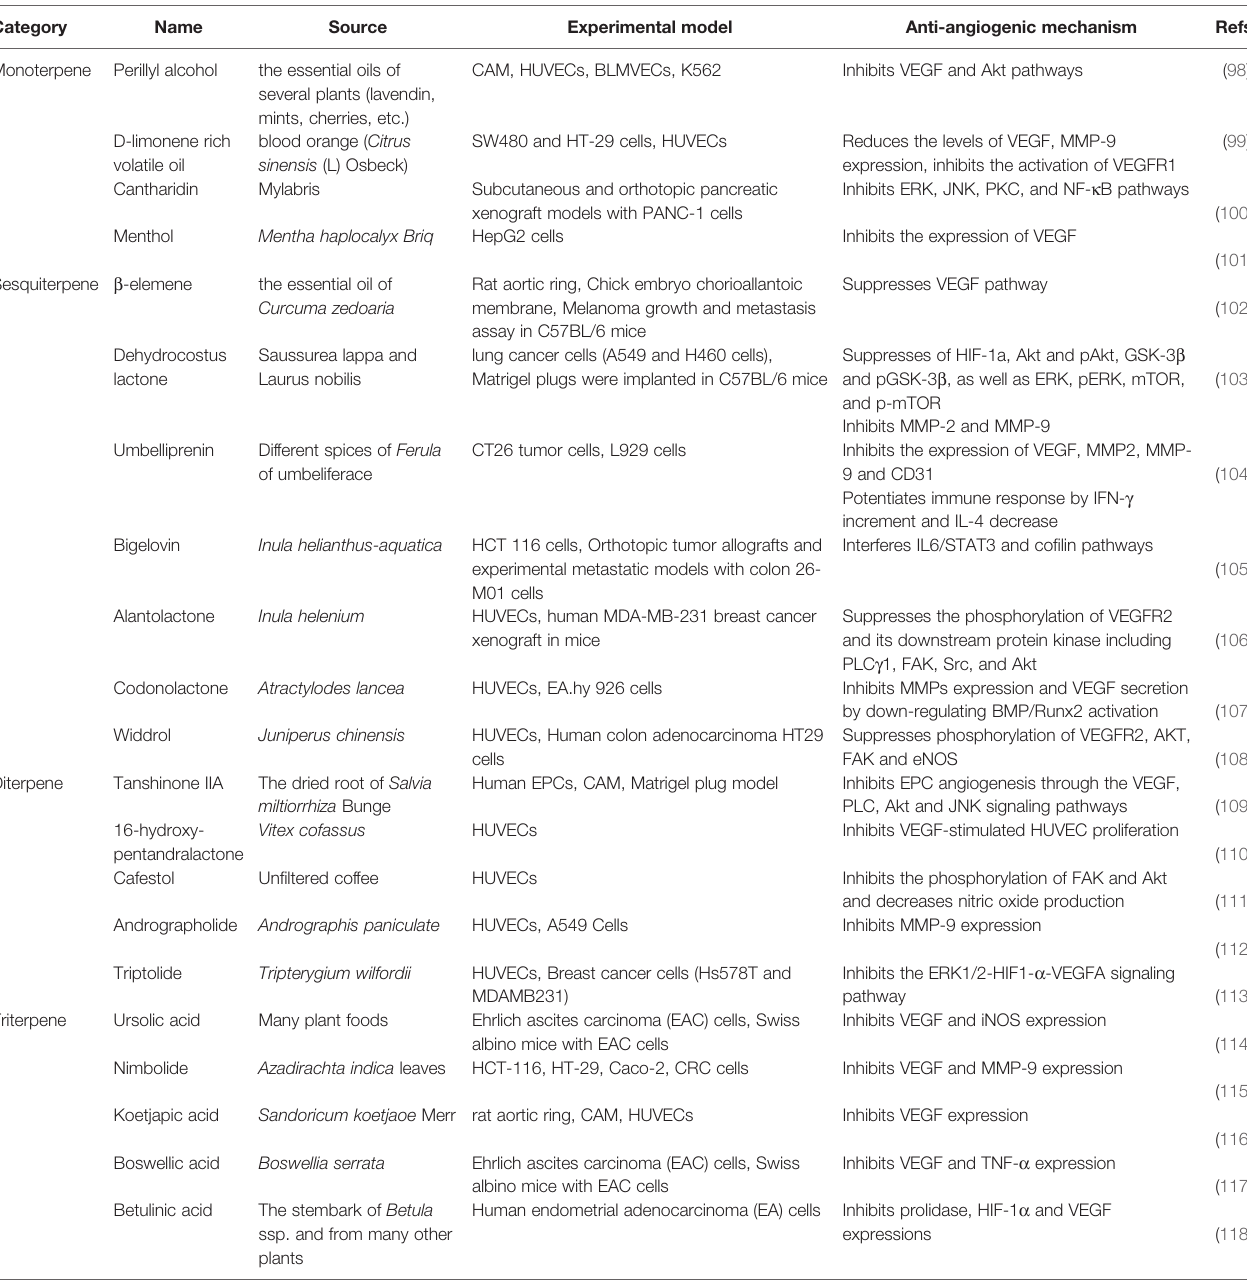
TABLE 5 | Natural anti-tumor angiogenesis terpenoids and their sources, experimental models and anti-angiogenic